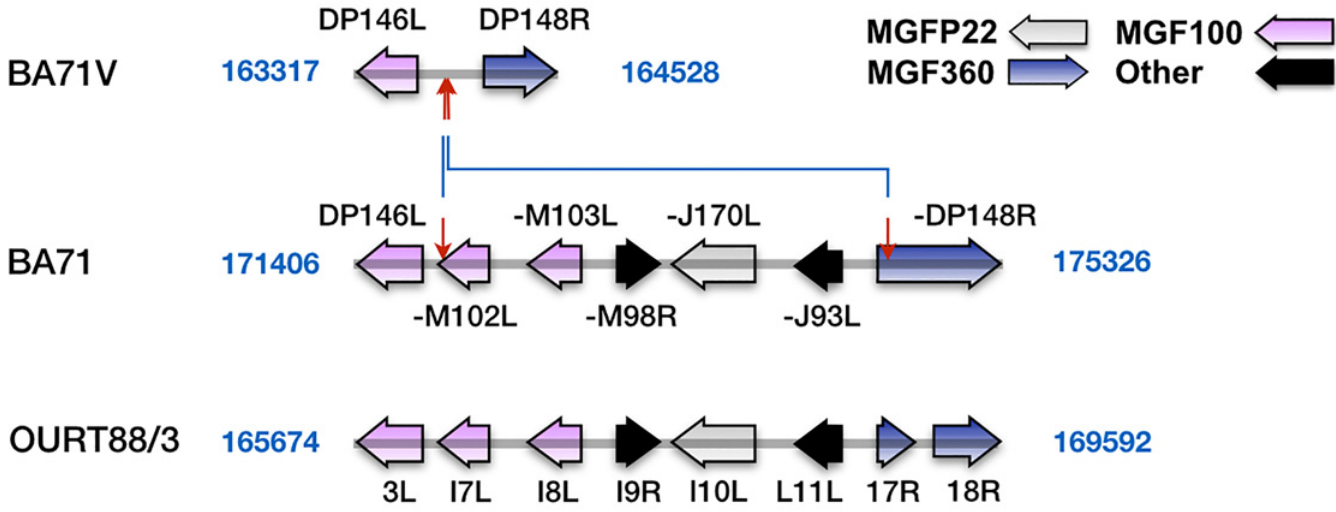
Fig 6. Comparison of the genomic structure of BA71 with BA71V and OURT88/3 around difference 49. The figure shows a representation to scale of the genomes of BA71, BA71V and OURT88/3 around the position of BA71-BA71V difference 49 (the exact positions are indicated for each of the genomes). Red arrows delimit non-identical regions. Blue lines connect arrows at equivalent positions. The different groups of ORFs are identified by colors as shown in the figure. The dash at the beginning of the names of some ORFs indicates where the prefix BA71- has been removed to avoid clutter.